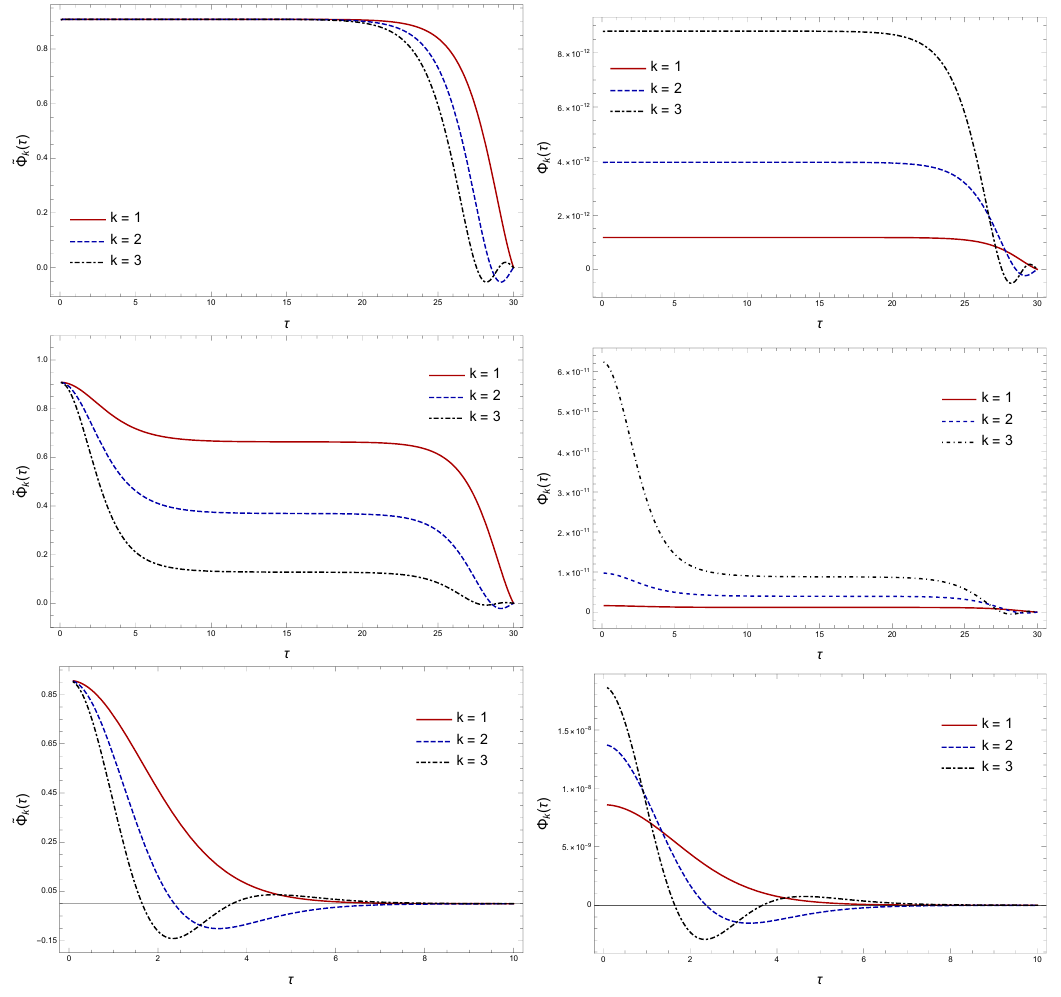
Figure 5 . Plot of ˜Φ k ( τ ) (left) and Φ k ( τ ) (right) with k = 1 , 2 , 3 , for different values of τ c = 0 , 15 , 30 and fixed T = 30 . When τ c = 0 (unwarped case) the wavefunctions spread as much as possible (given our boundary conditions) through the conifold, being constant for most of values of τ , and when τ c = T they localise at the tip τ = 0 . Wavefunctions for modes with higher k always have a larger amplitude than lower